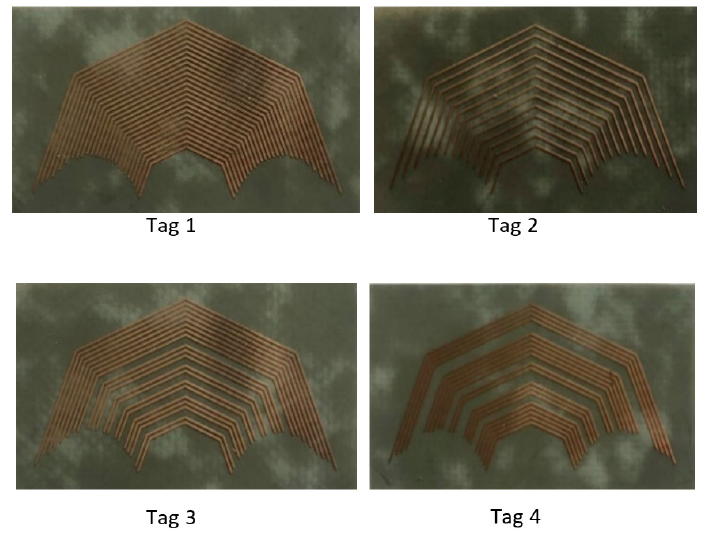
Figure 7. Fabricated prototypes of the tags.